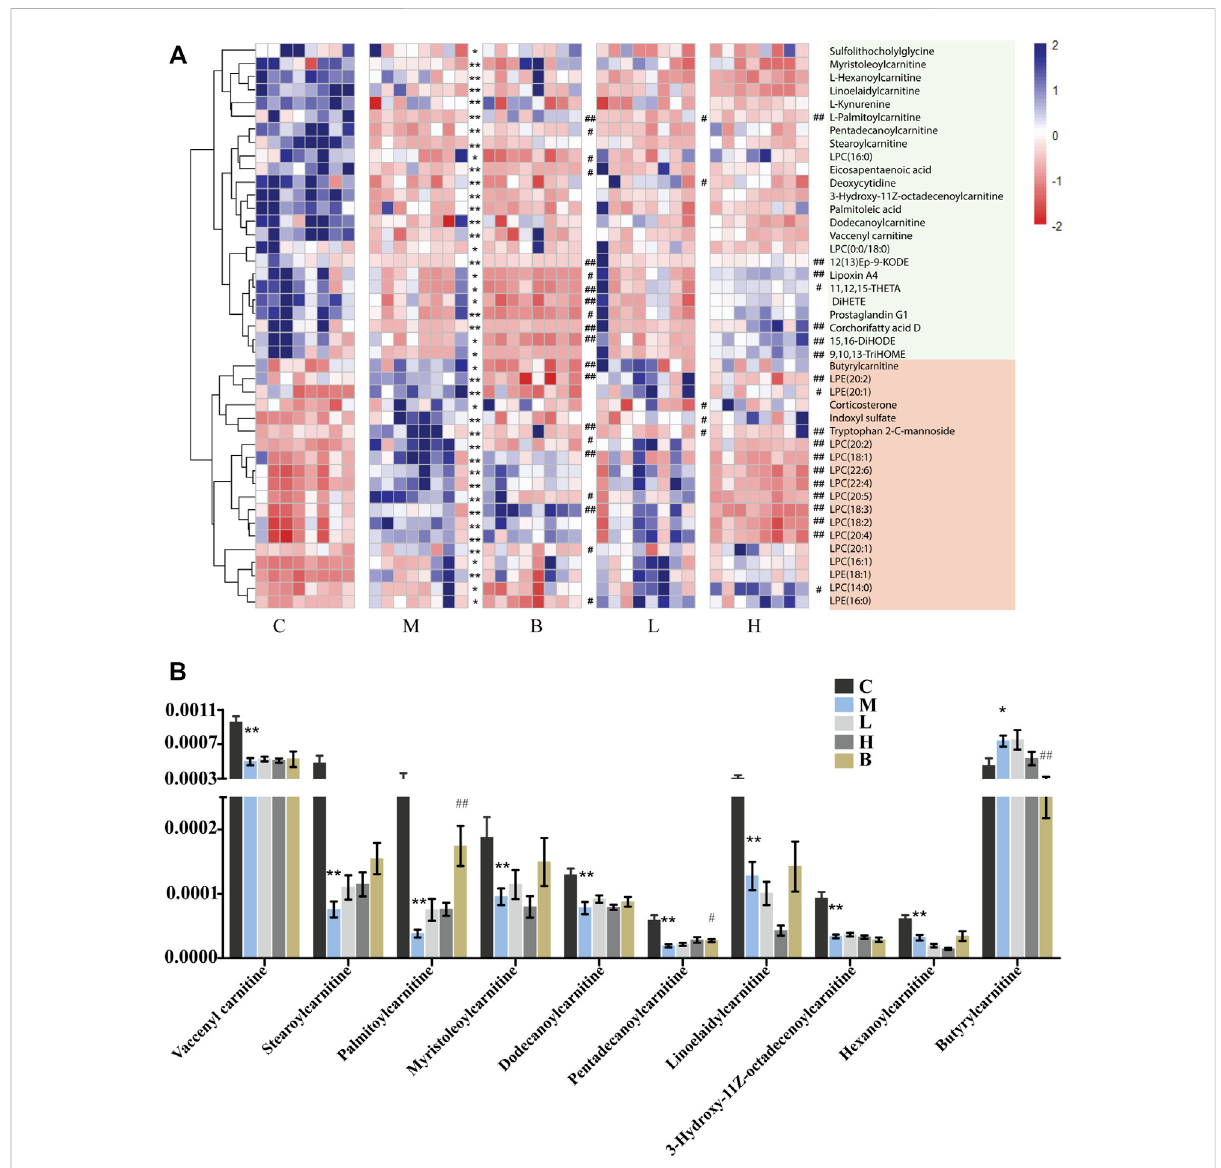
FIGURE 2 Differentially abundant metabolites intheplasmaofHUAratsincontrol group(C),HUA modelgroup(M),positivedrug (benzbromarone)group (B),low-doseAMUPgroup(L),andhigh-doseAMUPgroup(H). (A) HeatmapofthedifferentiallyabundantmetabolitesintheplasmaofHUArats.Each cellrepresentsonecompound. Deeperbluerepresentedhigher levelsanddeeperredrepresentedlowerlevels. (B) Comparisonofsignalintensity of signi fi cantly differentiallyabundantacylcarnitinesinthe fi vegroups.* p < 0.05comparedwithgroupC.** p < 0.01comparedwithgroupC;# p < 0.05 compared with group M; ## p < 0.01 compared with group